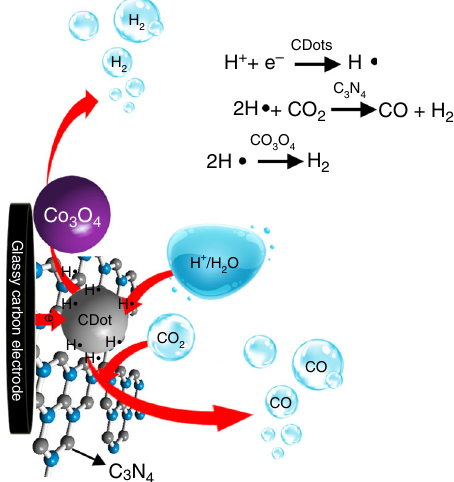
Fig. 2 Schematic diagram of the reaction mechanism induced by Co 3 O 4 - CDots-C 3 N 4 . CDots are the generation site of H (cid:129) , Co 3 O 4 the generation site of H 2 , and C 3 N 4 the generation site of